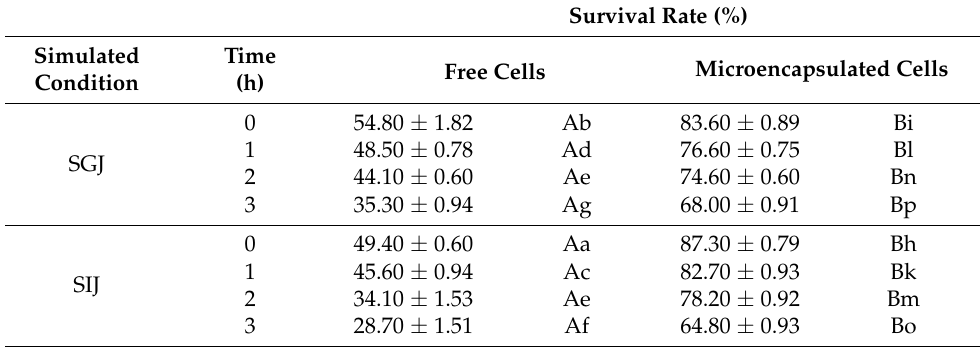
Table 6. Effects of SGJ and SIJ on the survival rate of free and microencapsulated (alginate+xanthan gum) L. rhamnosus